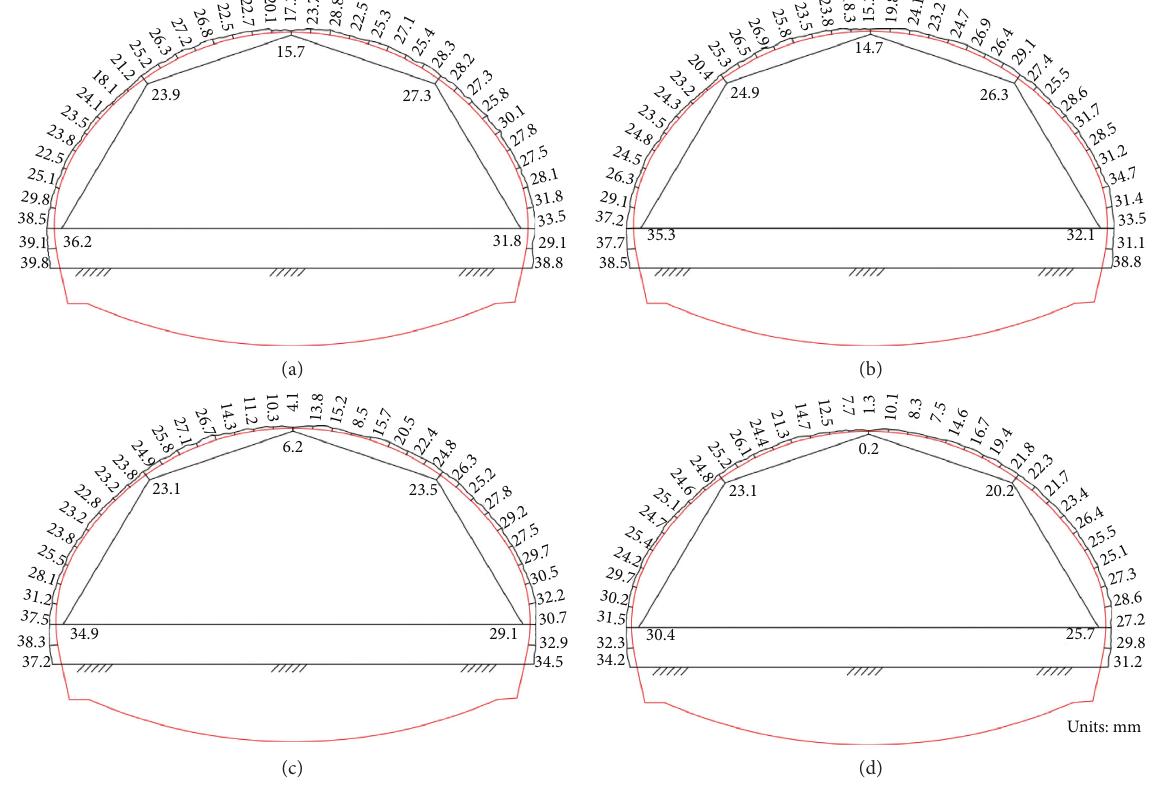
Figure 16: 3D laser scanning and total station section measurement data comparison. (a) DK68 + 415. (b) DK68 + 425. (c) DK68 + 435. (d) DK68 + 445. Table 4: Statistical table of primary support clearances of tunnel. Tunnel clearance (mm) Mileage Vault Left arch Left